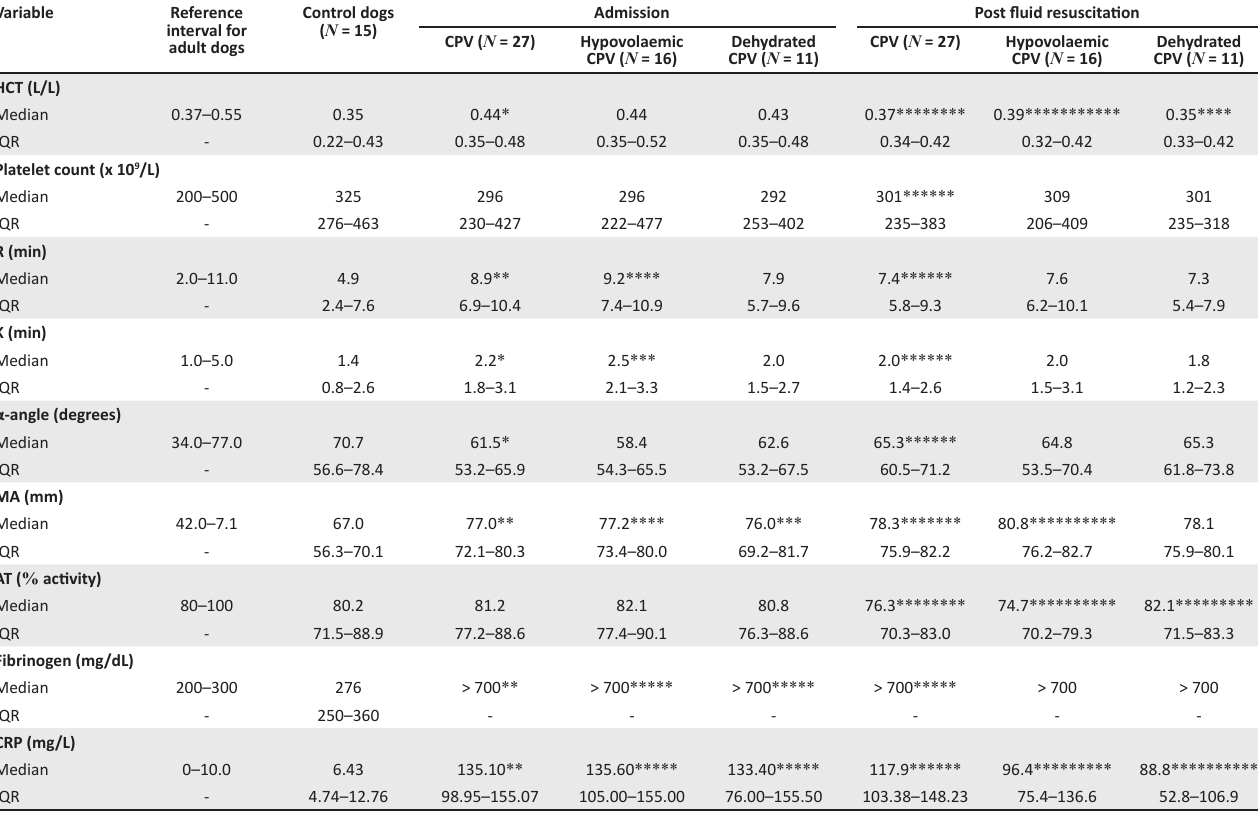
TABLE 2: Haemostatic and inflammatory variables in the canine parvovirus group, canine parvovirus subgroups and control group at admission and post fluid resuscitation. Variable Reference Control dogs interval for ( N = adult dogs